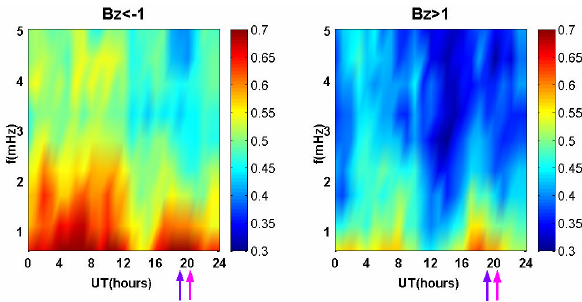
Fig. 3. Daily distribution of the average coherence for Bz< − 1nT Figure 3 and Bz> 1nT, where Bz is the north-south component of the IMF. Pink and violet arrows indicate local geomagnetic noon at TNB and SBA,